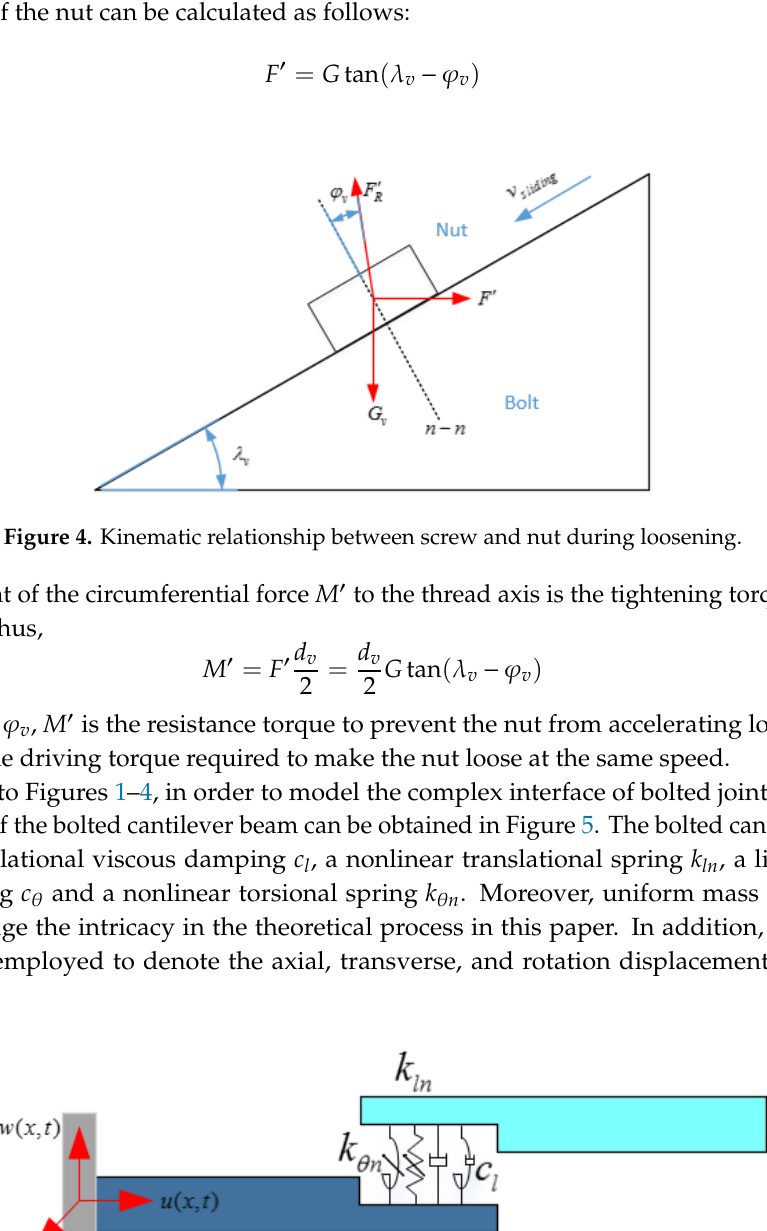
Figure 5. Schematic diagram of bolted cantilever beam.